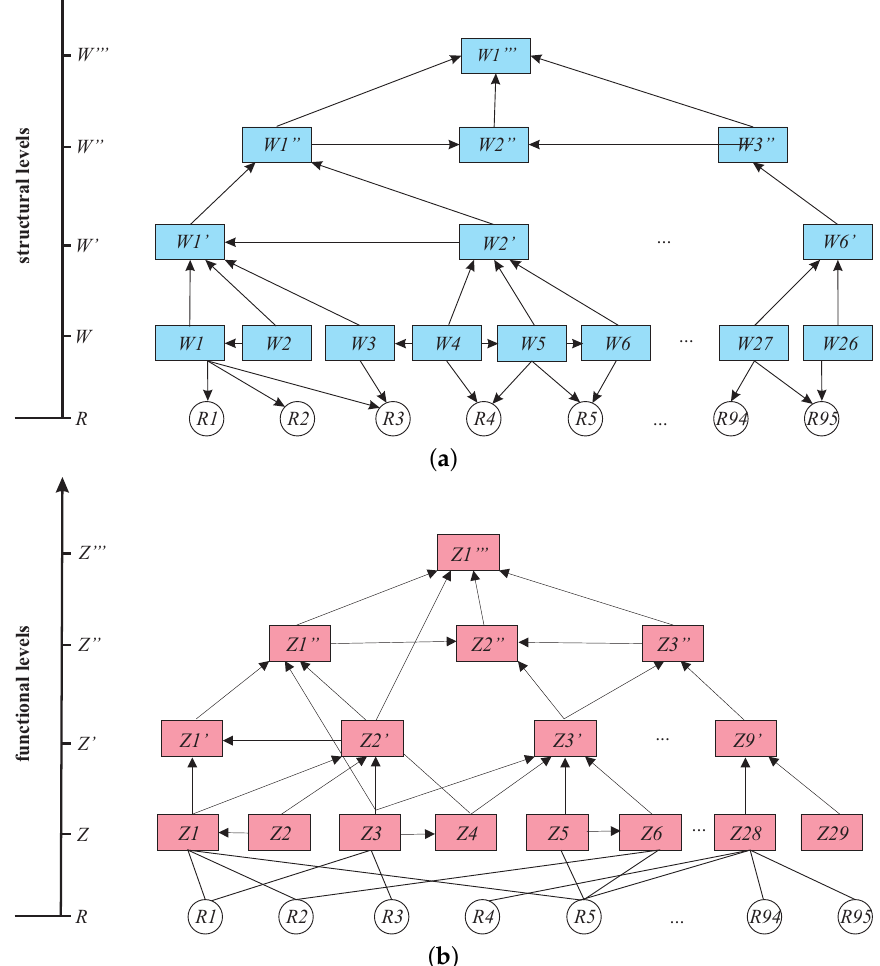
Figure 8. Fragments of graphs depicting a learning situation from the structural ( a ) and functional ( b ) points of